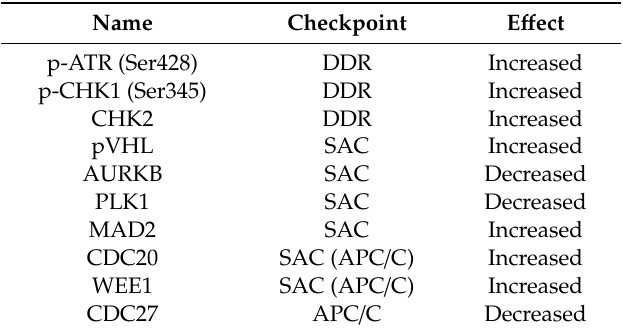
Table 1. Changes in the expression level of spindle assembly checkpoint (SAC) and DNA damage response (DDR) proteins upon Kv10.1 downregulation in synchronized HeLa